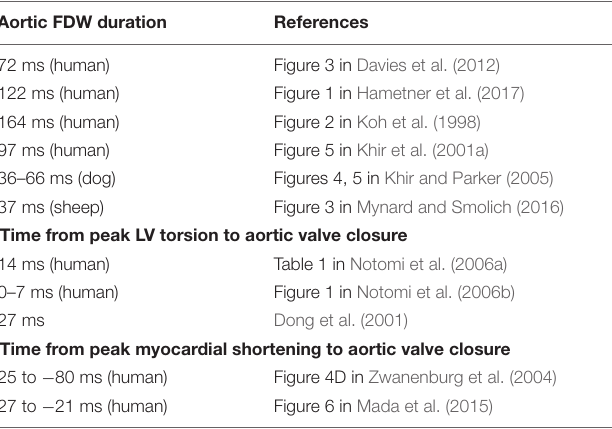
TABLE 2 | Timing of aortic forward decompression wave duration and onset of LV